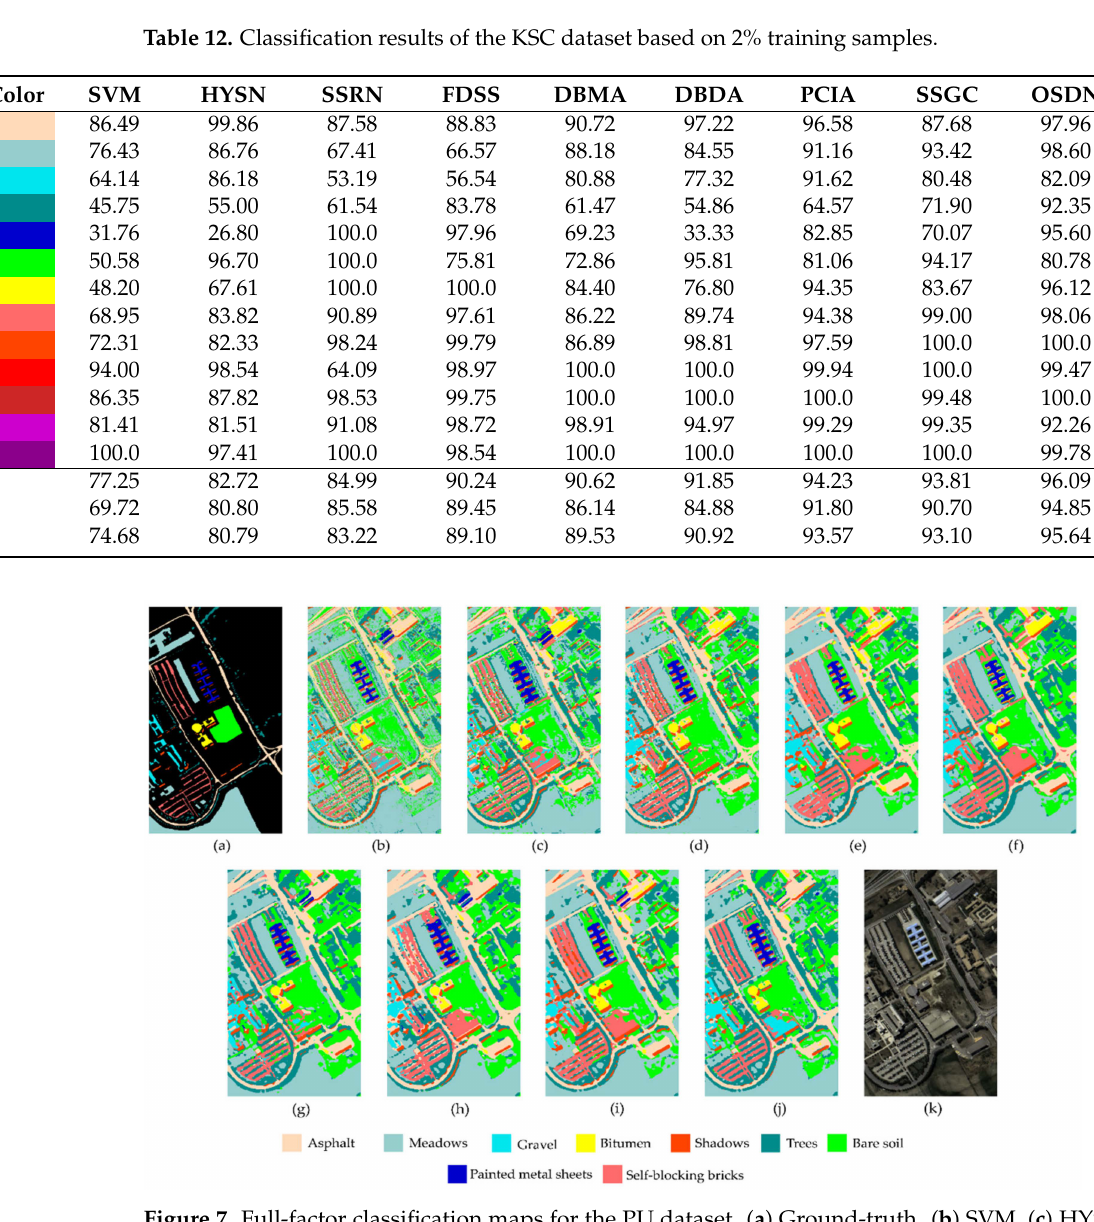
Figure 7. Full-factor classification maps for the PU dataset. ( a ) Ground-truth. ( b ) SVM. ( c )